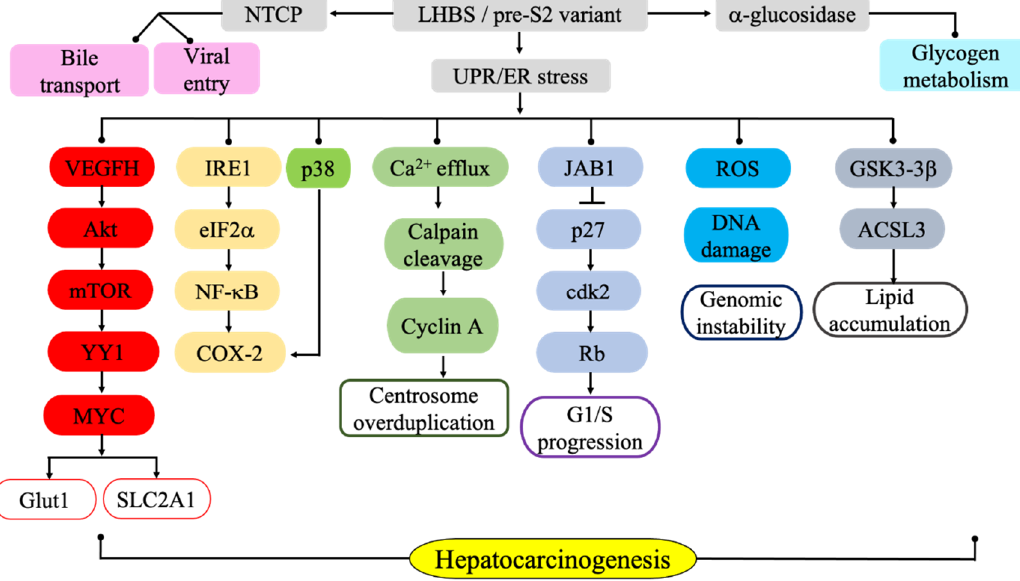
Figure 2. Involvement of the HBV large surface protein in viral entry, glycogen metabolism, and ER stress-associated carcinogenic pathways.